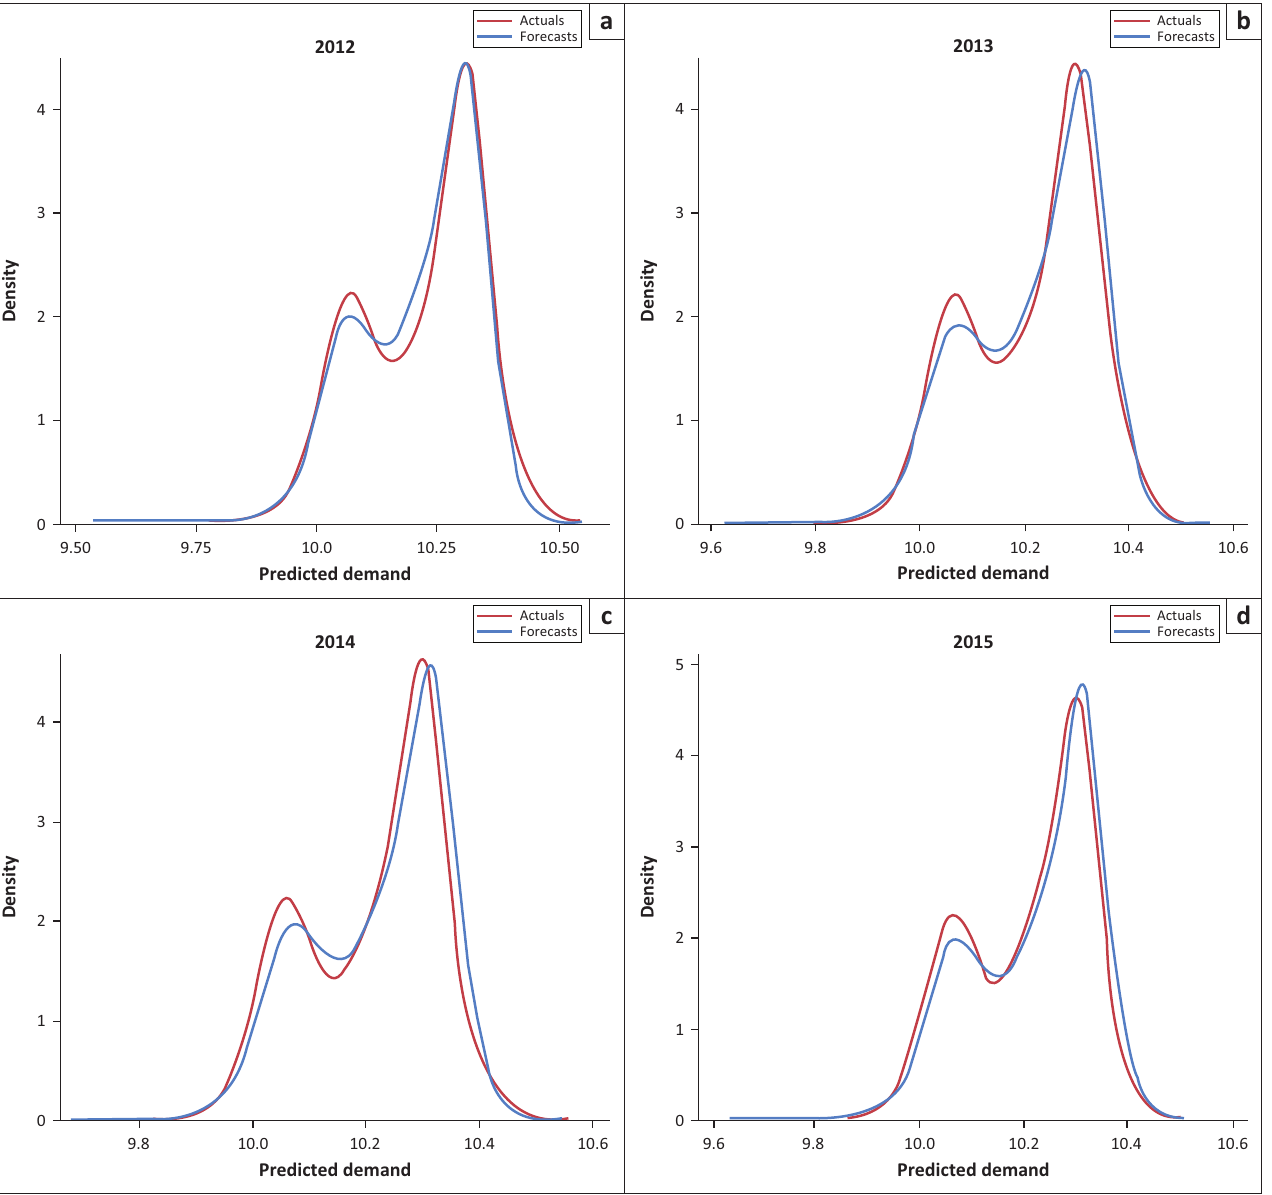
FIGURE 3: Comparison of actual and forecasted demand distributions: (a) 2012; (b) 2013; (c) 2014 and (d)